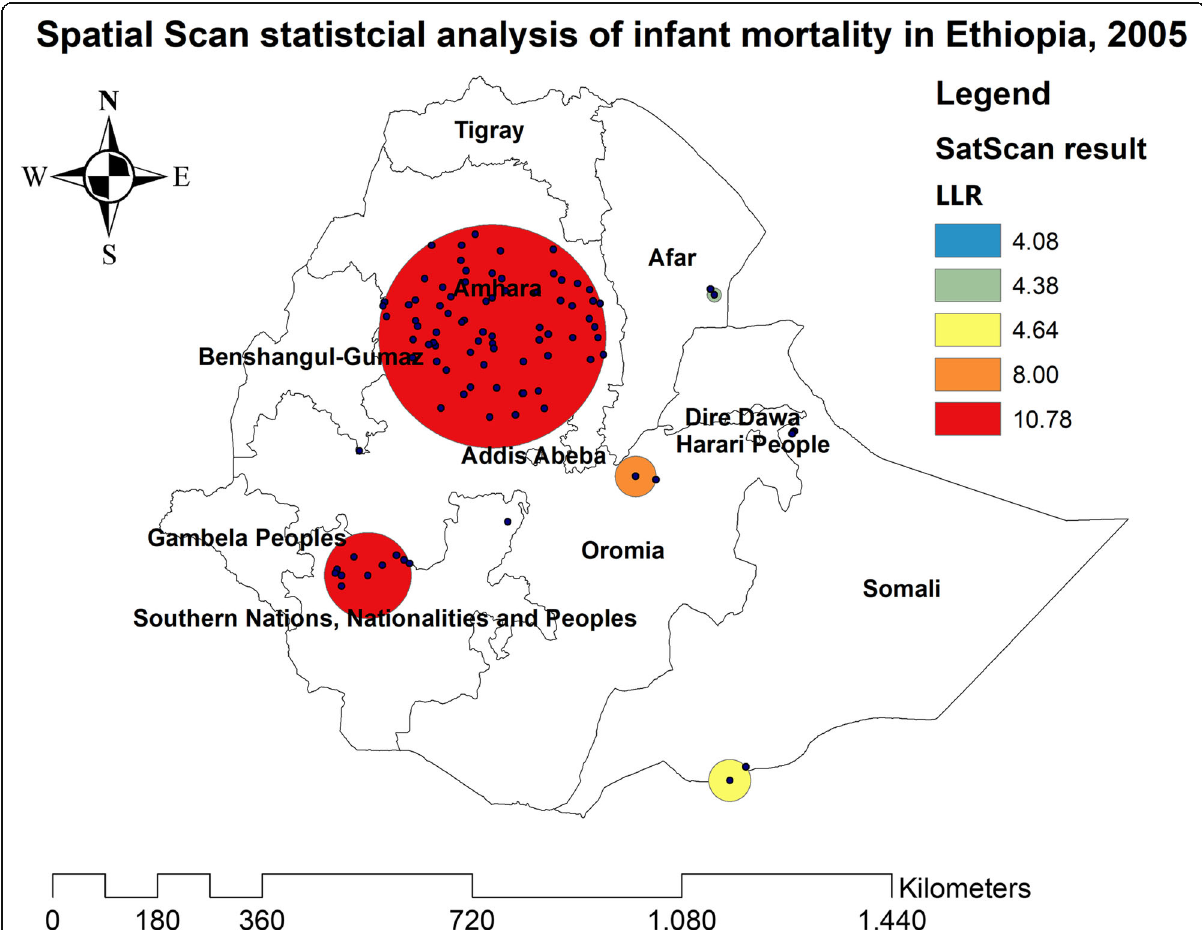
Fig. 3 The SaTScan analysis of infant mortality in Ethiopia in 2005